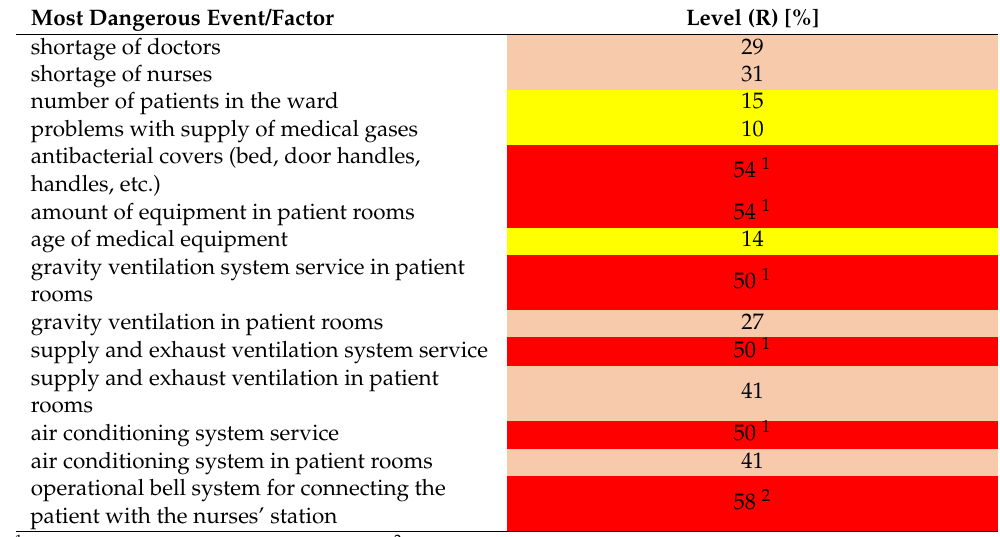
Table 8. Relative risk (R) for the gravest events/factors in the category of a given ward—the Intensive Care and Anesthesiology Unit (human and technical factors).